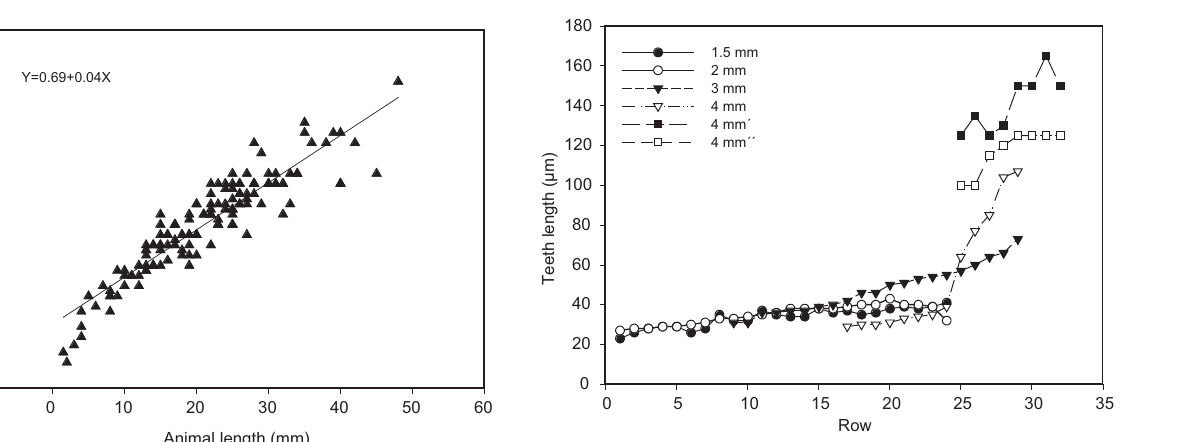
F IG . 7. – Size of the outer lateral tooth in each row of the radula rib- bon in specimens up to 4 mm in length. The arrow indicates the beginning of the radula part. Individuals 4 mm in length without a pre-radula are